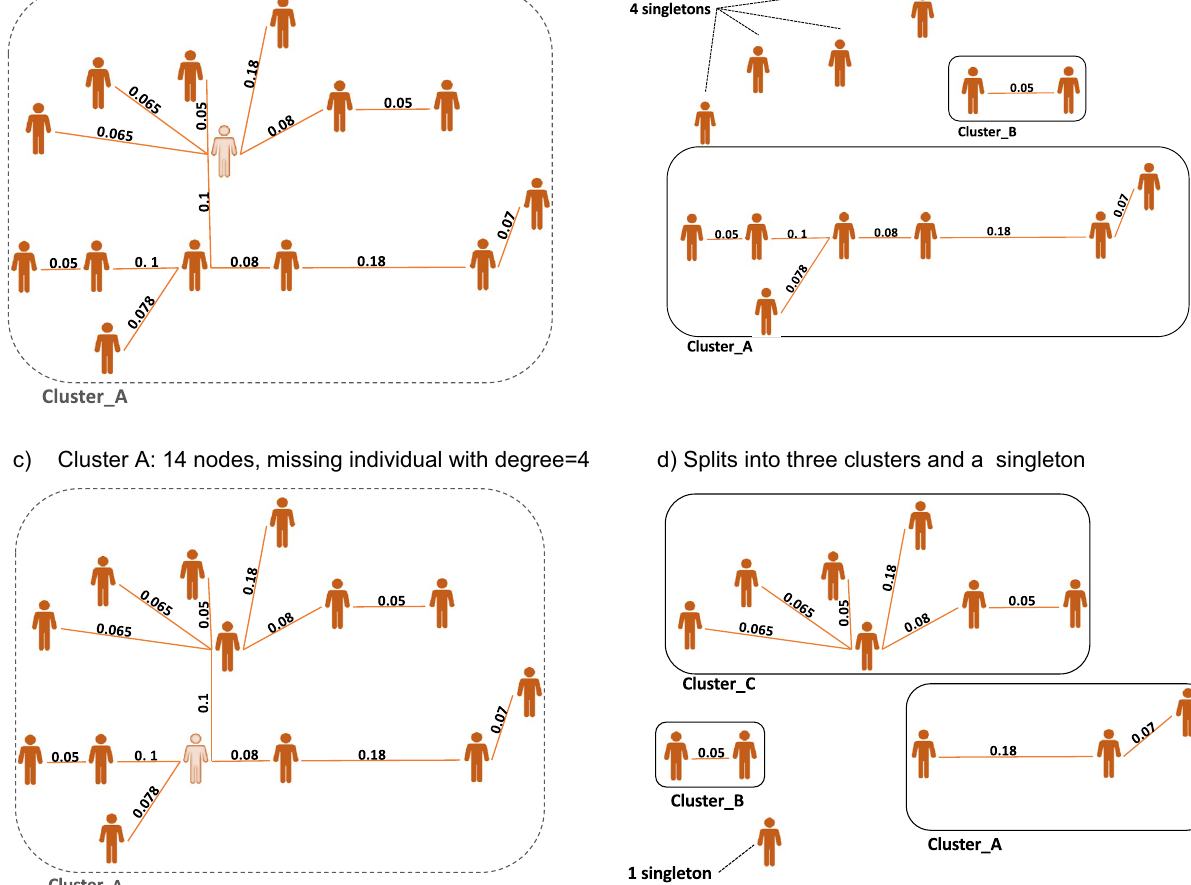
Figure 2. Example of how missing one node in a network can change its clustering dynamics: ( a ) cluster A with 14 individuals and their pairwise genetic distance, ( b ) missingness of one node (degree = 6), causes cluster A to split into two smaller clusters and also leaves 4 nodes as singletons, ( c ) repeating cluster A with another node missingness (degree = 4), ( d ) the new missingness, caused cluster A split into three smaller clusters and to leave one node as